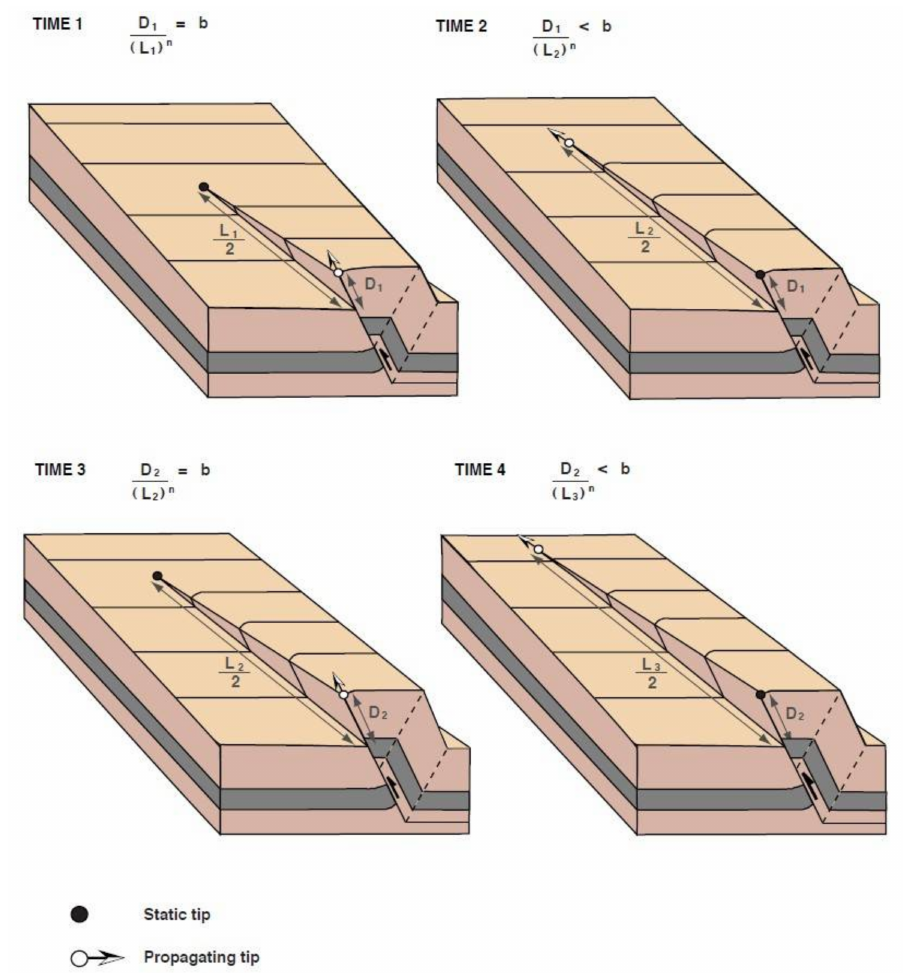
Figure 3. Illustration of the manner in which the modelled faults and folds grow in the modelling scheme, after Bernal et al.